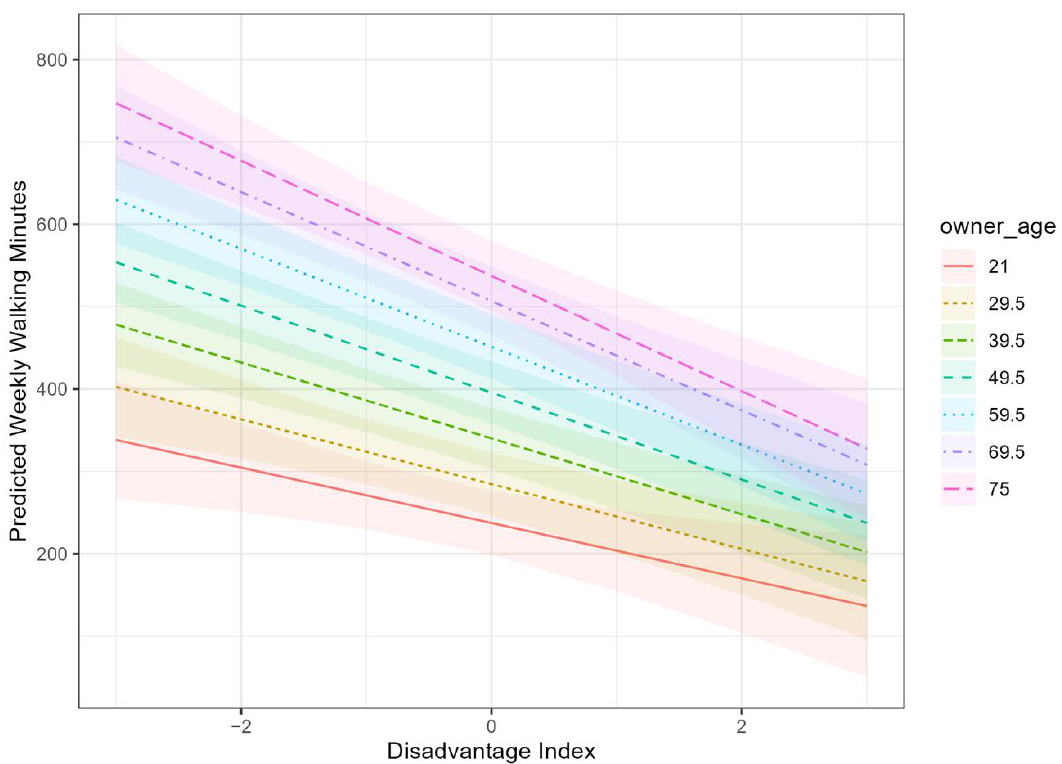
Figure 2. Predicted Weekly Walking Minutes by Age and Neighborhood Disadvantage from Model